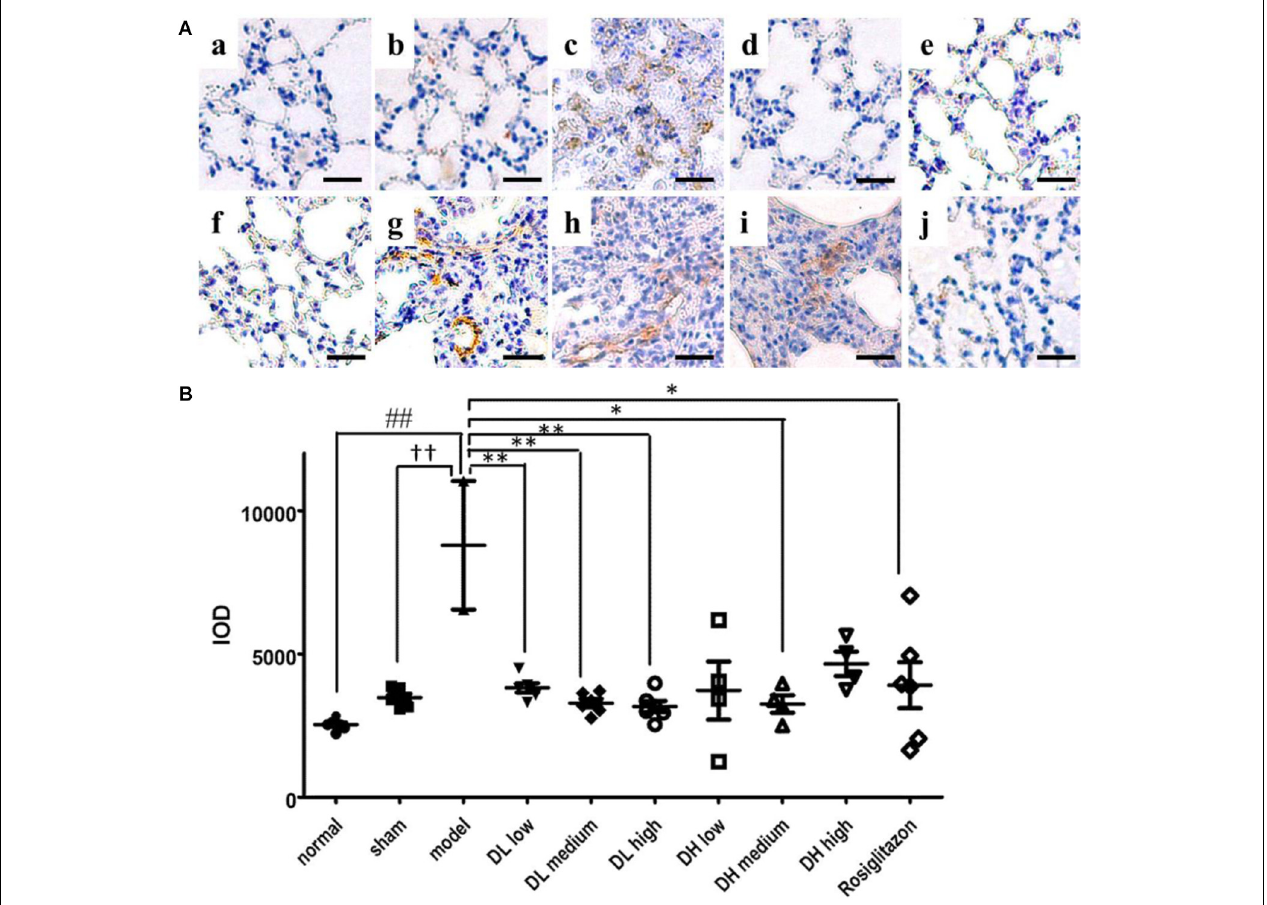
FIGURE 4 | DLP reduces BLM induced upregulation in pulmonary α -SMA expression in mice. (A) Representative images of immunohistochemical staining for α -SMA protein in lung tissues. Scale bar = 50 µ m. Panel indicator a, normal; b, sham; c, model; d, DL low dose; e, DL medium dose; f, DL high dose; g, DH low dose; h, DH medium dose; i, DH high dose; j, ROS. (B) Integral optical density of α -SMA positive expression in lung tissues. IOD: integral optical density. Results are expressed as the mean ± standard deviation. ## P < 0.01 versus the normal group; †† P < 0.01 versus the sham group; ∗∗ P < 0.01 and ∗ P < 0.05 versus the model